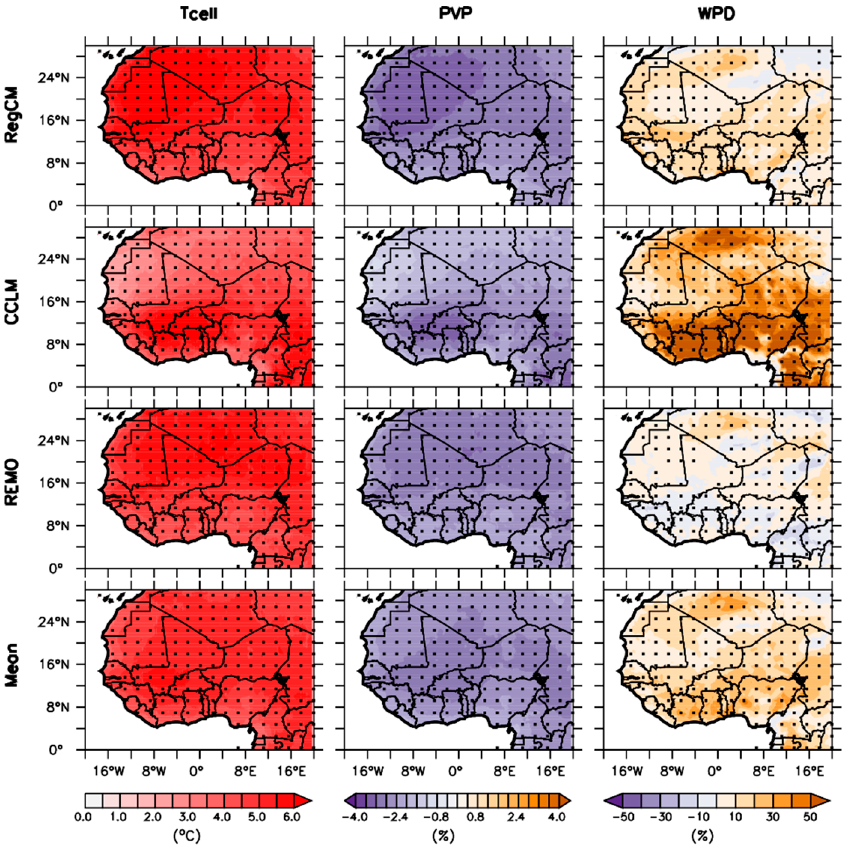
Figure 11. Same as Figure 10, but for the far future (2071–2100) and under the RCP8.5